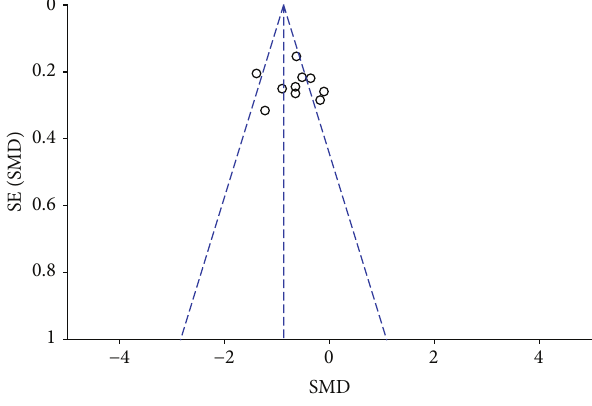
Figure 8: Funnel plot of 24h VAS